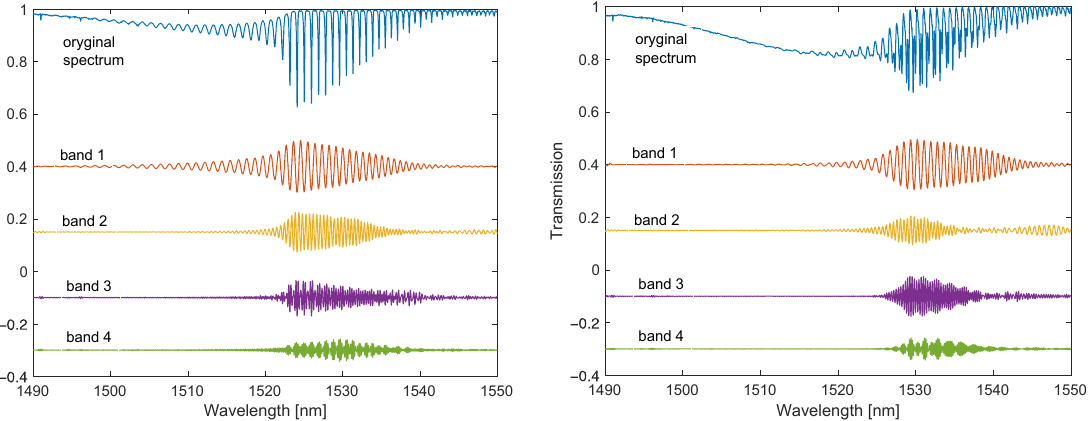
Figure 11. Optical spectra: original and band-filtered for individual frequency bands for TFBG and DC-TFBG (SRI = 1.4012).